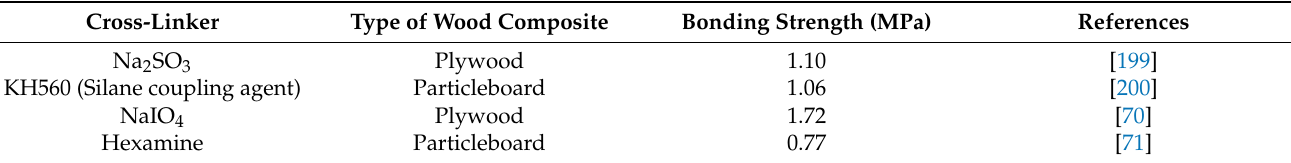
Table 3. Lignin-based PU adhesives and their application for wood